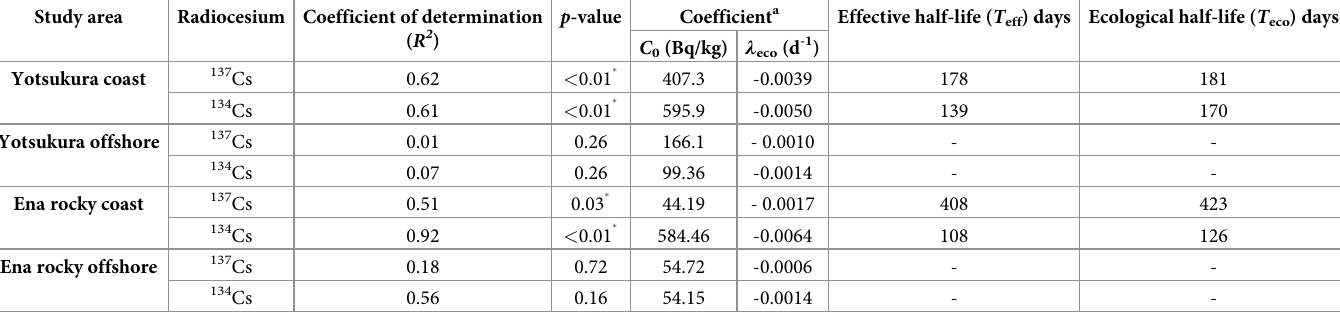
Table 2. Summary statistics of the 137 Cs and 134 Cs radioactivity, effective half-life ( T eff , day), and ecological half-life ( T eco , day) in sea urchin gonads collected from the four sampling points (Yotsukura coast and offshore areas, and Ena rocky coast and offshore areas). Study